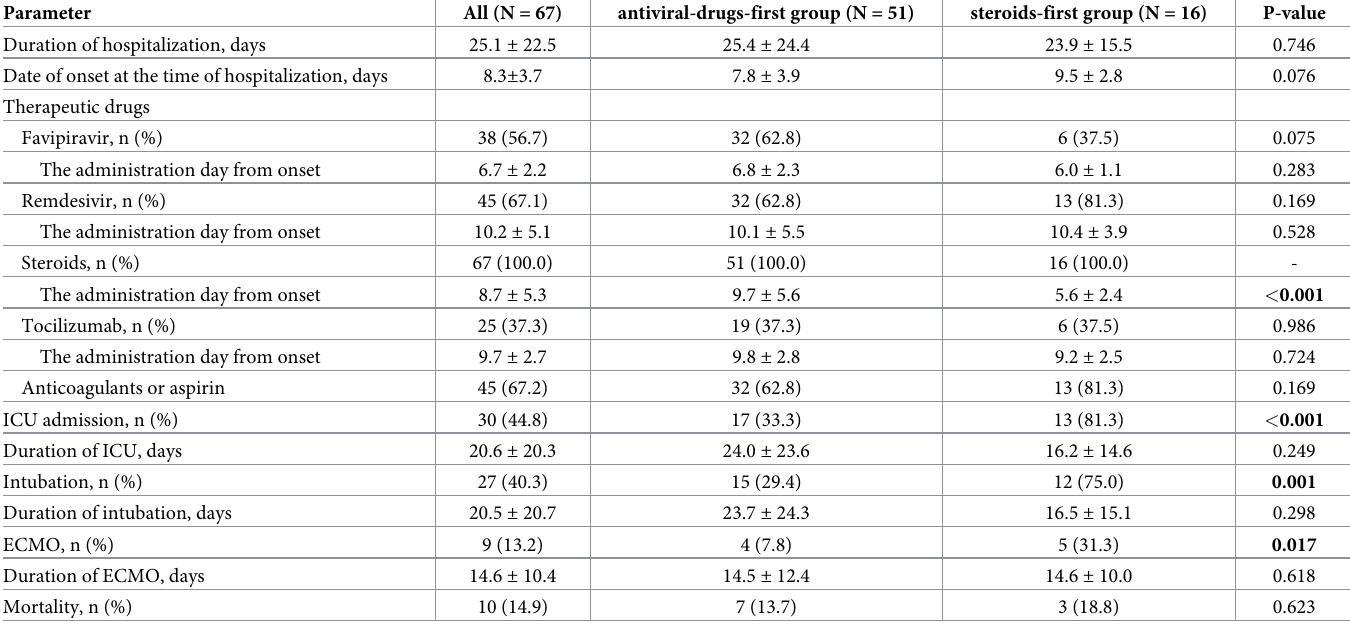
Table 2. Overview of treatments for COVID-19 and course of the disease (n =